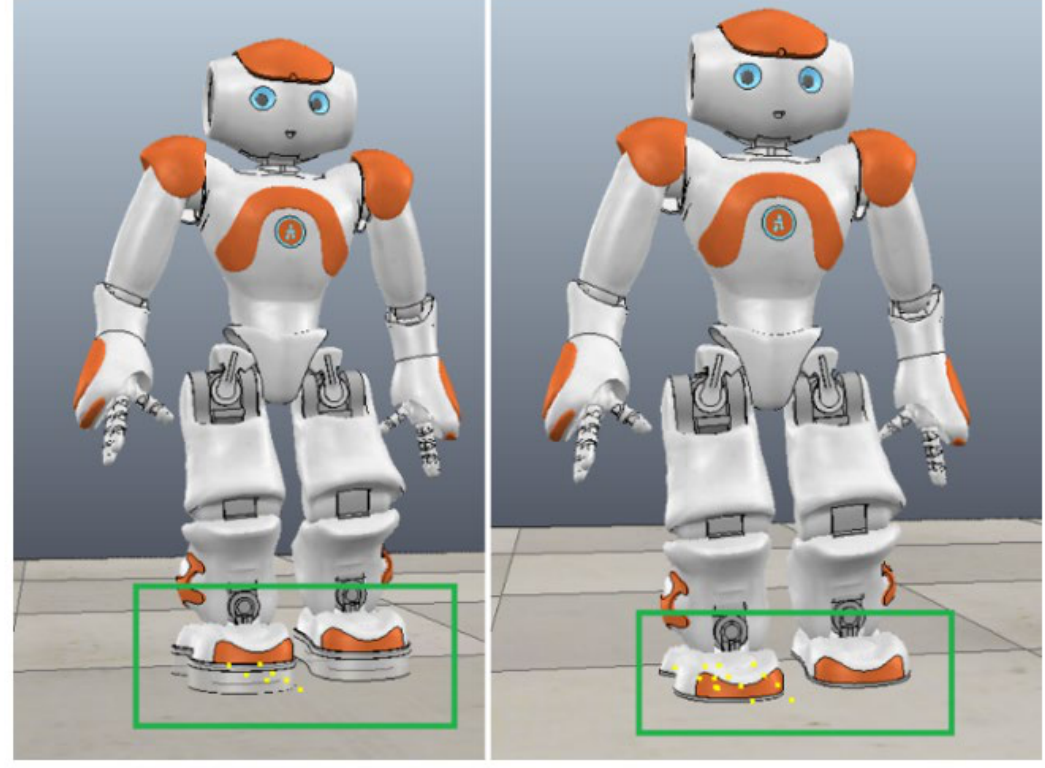
Figure 4. NAO simulated with (left) and without (right) the shoes. The yellow dots are the contact points between the foot and the